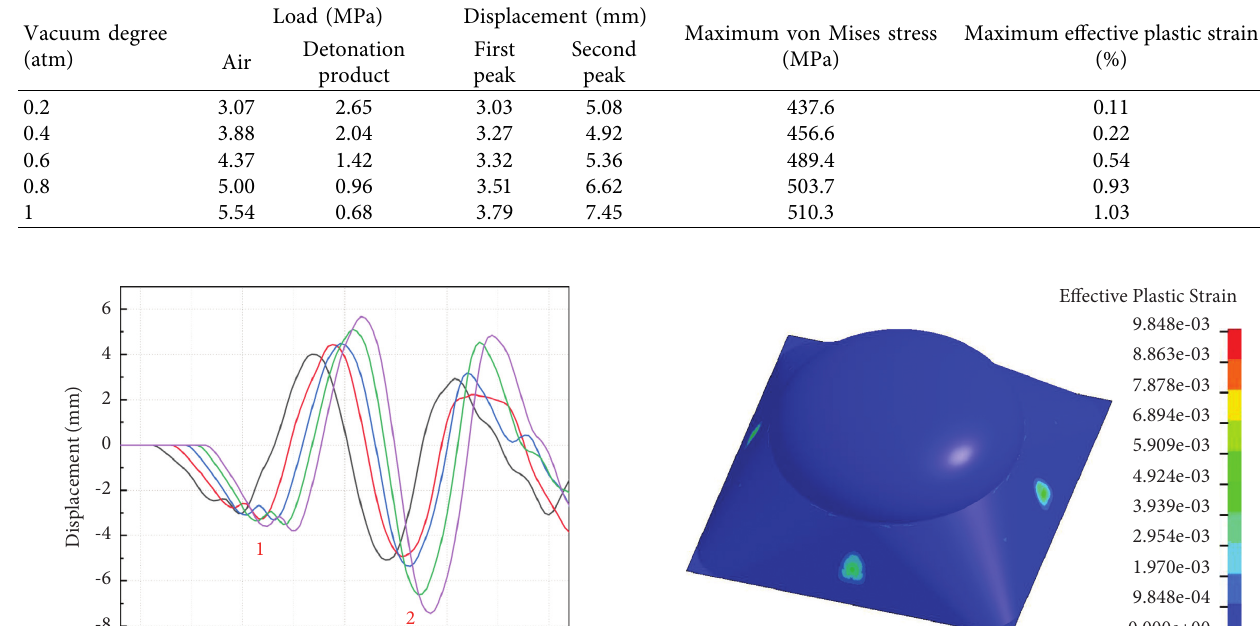
Table 6: Displacement, von Mises stress, and effective plastic strain of the EBD under different vacuum degrees.